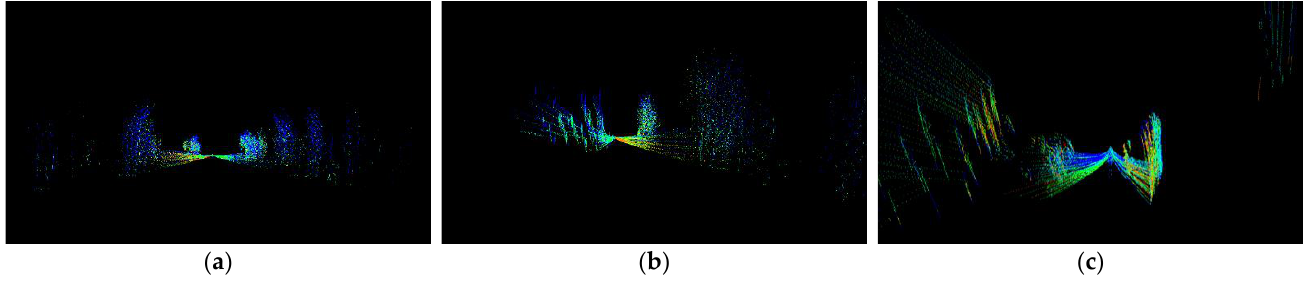
Figure 9. Point cloud image scene 5: Heating-S16 ( a ) Picture 1, ( b ) Picture 2, ( c ) Picture 3.